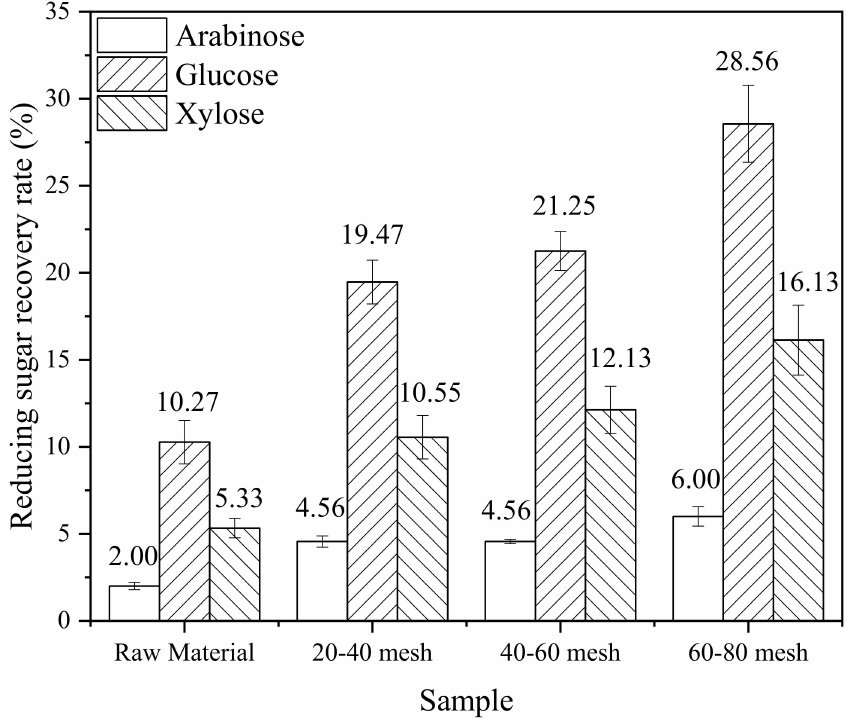
Figure 4. Enzymatic hydrolysis recovery rates of monosaccharides after thread rolling and